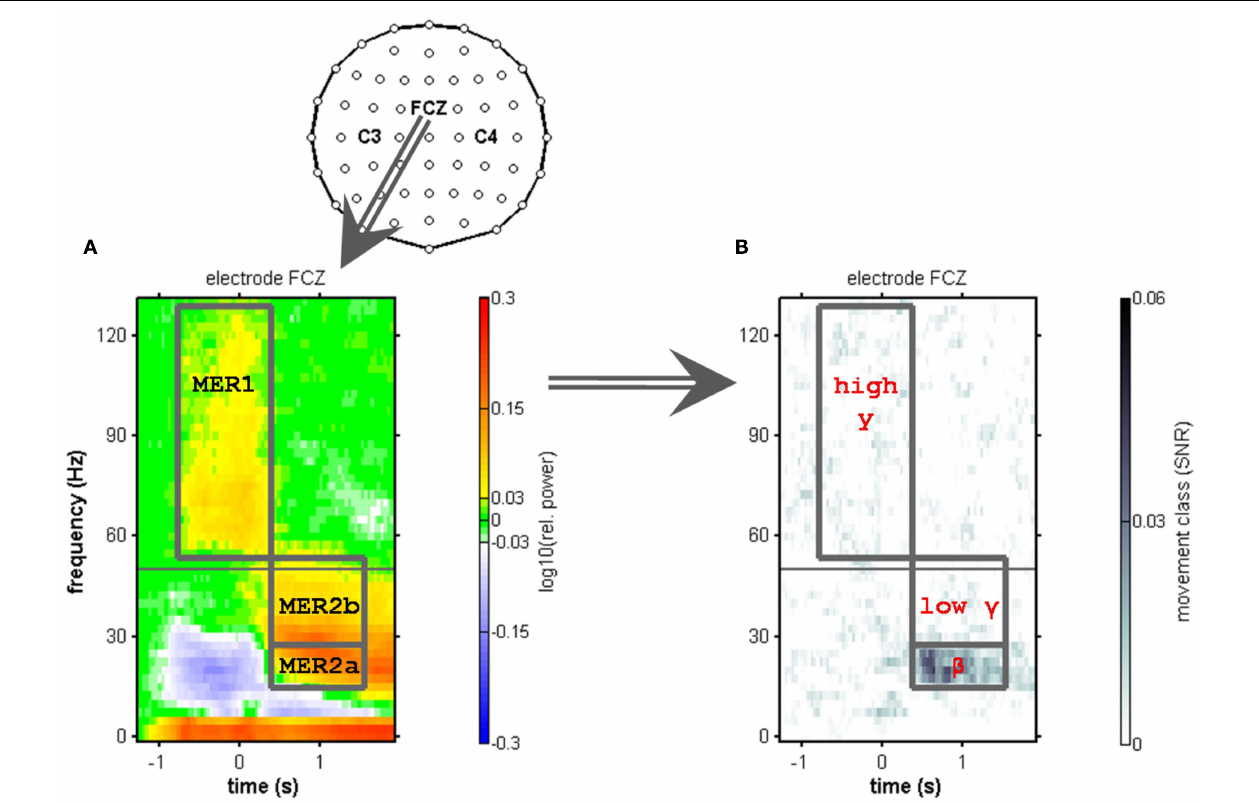
(55–120Hz range).We refer to this high- γ response as movement end-related response 1 (MER1). After movement end, a power